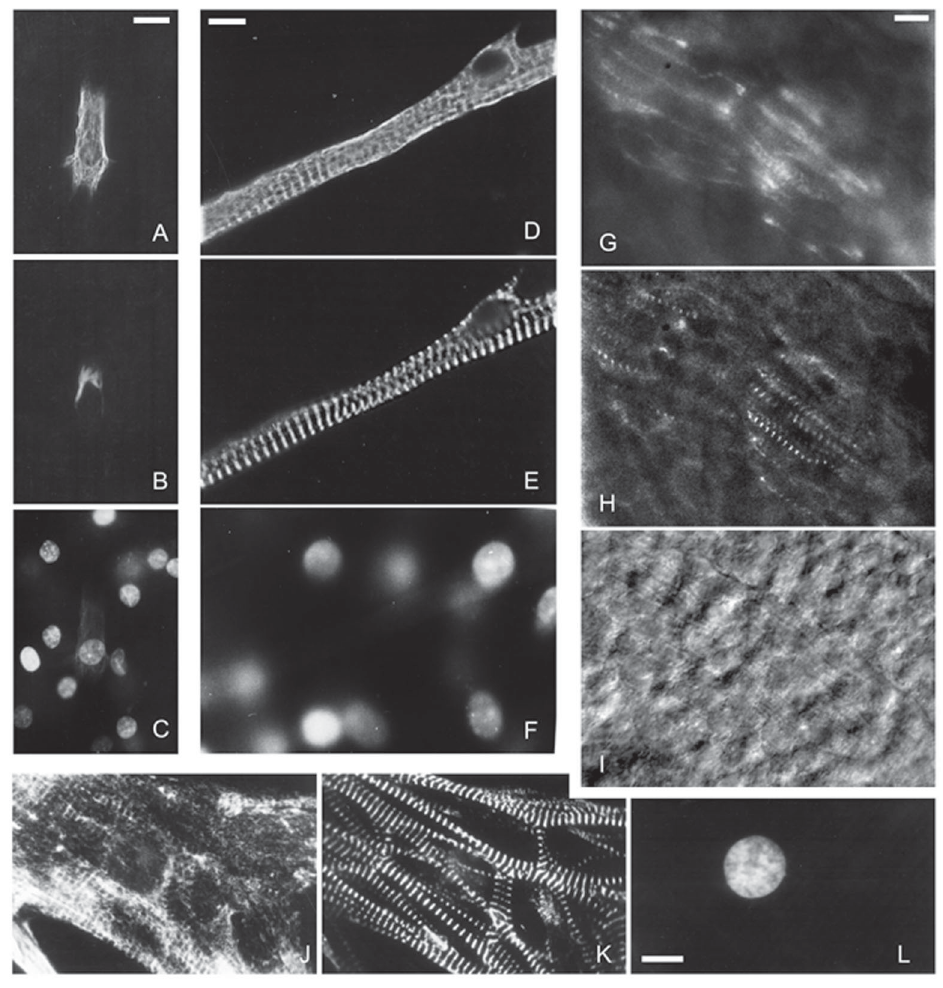
Figure 3. Desmin distribution in several cell types detected by immunofluorescence. One-day-old cultured skeletal muscle chick cell, stained for desmin (A), myosin (B) and DNA (4',6-diamidino-2-phenylindole dihydrochloride) (C). At this developmental stage, myoblasts are beginning to elongate, desmin is distributed throughout the cyto- plasm, and myosin appears first around the nucleus. Five-day-old cultured skeletal muscle chick myoblast stained for desmin (D), Z-line titin (E) and DNA (F). This myoblast is already striated for desmin and titin. Desmin is present on the Z-line, but not as restricted as titin. There is also desmin around the nuclei and diffusely in the cytoplasm. Twenty-four-hour zebrafish somites stained for desmin (G), α -actinin (H) and differential interference contrast (I). These 2-hour-old myocytes in the fish embryo show a pattern similar to the 5-day chicken culture, with striations visible by desmin and α -actinin stain and by differential interference contrast. Three-day-old cultured heart chick cell stained for desmin (J), α -actinin (K) and DNA (L). In cardiac myocytes, desmin distribution on the Z-line is more restricted than in skeletal muscle, but there is also more desmin in the cytoplasm. The myofibrils are not aligned as in skeletal muscle, as can be seen by the α -actinin stain. Scale bar: 10 µm for all panels. For details, see Refs. 22 and